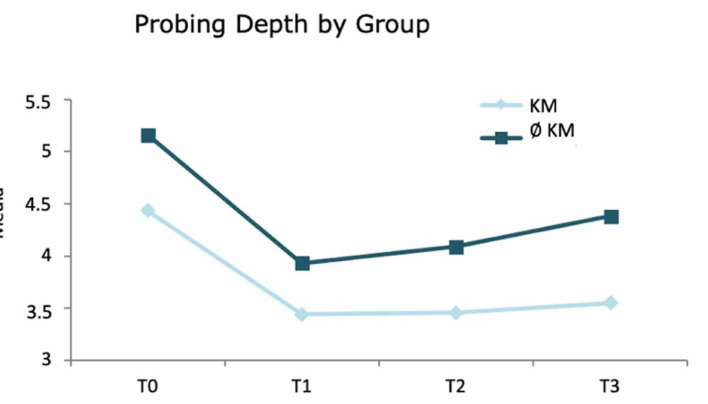
Figure 4. Changes in probing depth according to KM Group: Simple linear regression results with GEE model.